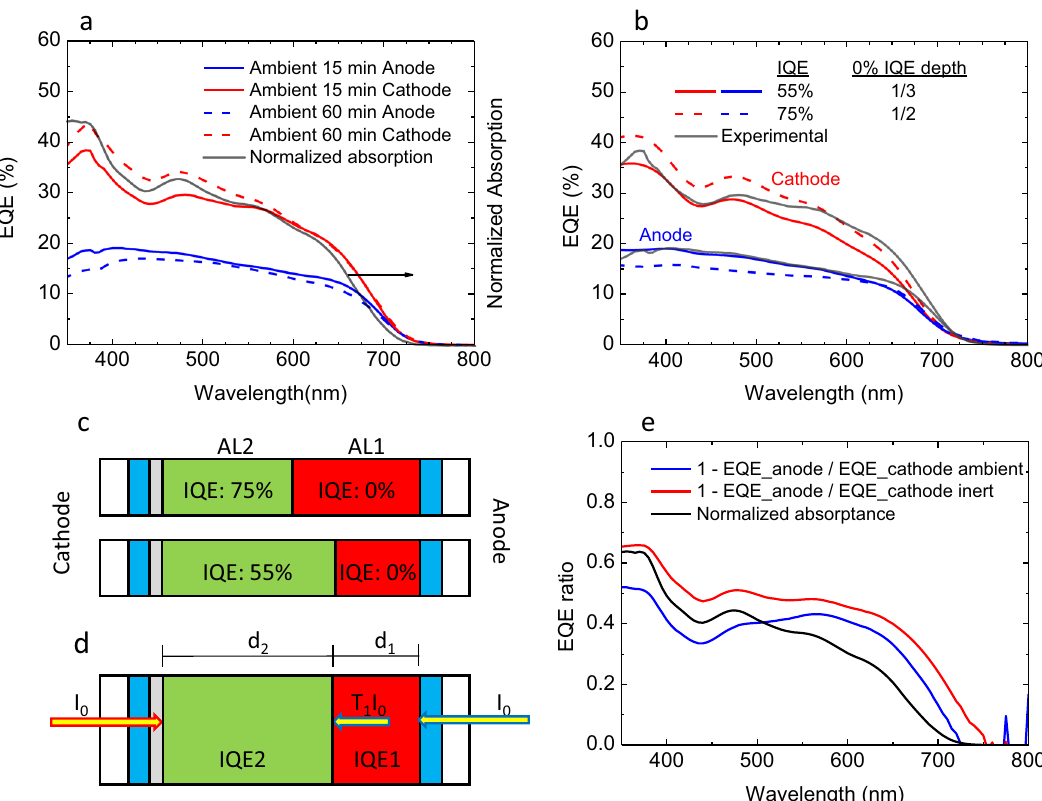
Fig. 4 Non contributing zone a Experimental EQE for devices exposed to ambient for 60 (dash) and 15 (solid) minutes illuminated through the anode (blue) and cathode (red), and the active layer absorption (black). b TMM simulated EQE for devices with 0% IQE on the anode half and 55% IQE on the cathode half (solid), 0% IQE in 1/3 of the device close to the anode and 75% IQE in the cathode side (dash) and experimental EQE from panel a (gray). c Illustration of the position of the areas with different IQE used in b . The active layer is divided in working (green) and dead (red) areas. d Schematic illustration of the (1 — EQE ratio) calculation. A part of the active layer with thickness d 1 and 0% IQE on the anode side reduces the illumination intensity incident upon the working part by transmission through the dead layer, T 1 . e 1 — EQE ratio for a device cast under inert conditions (red), a device exposed to ambient (blue) and the scaled absorption coef fi cient of the AL